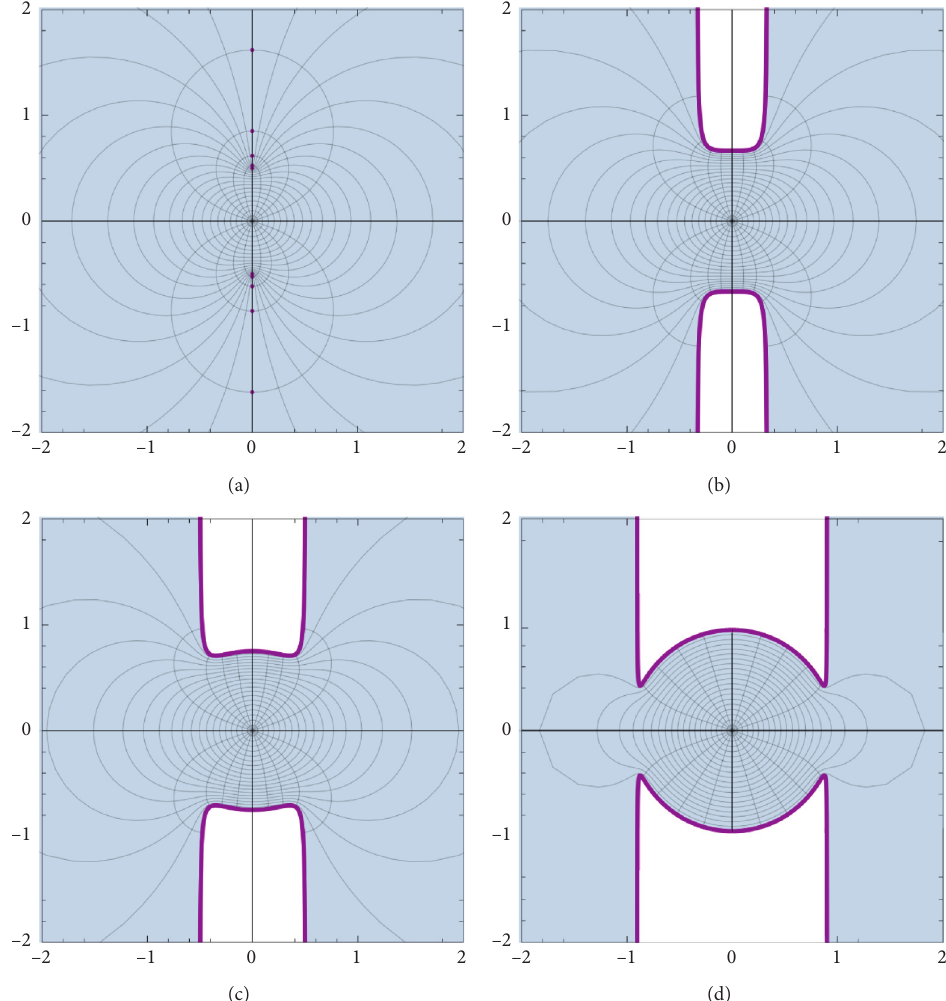
Figure 8: Images of (a) K